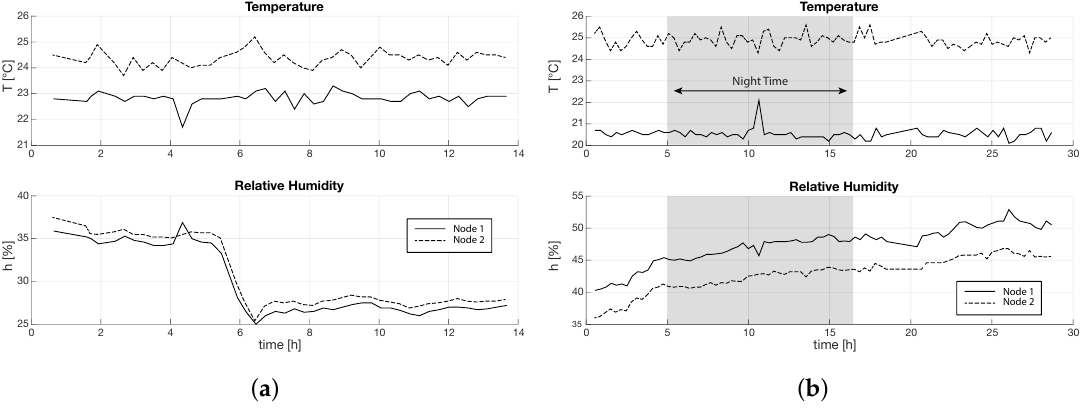
Figure 11. Temperature and relative humidity plots of data collected in the center VSN node in the hot aisle and in the center VSN node in one of the cold aisles. The grey region of ( b ) is the night period. ( a ) First campaign; ( b ) second campaign.